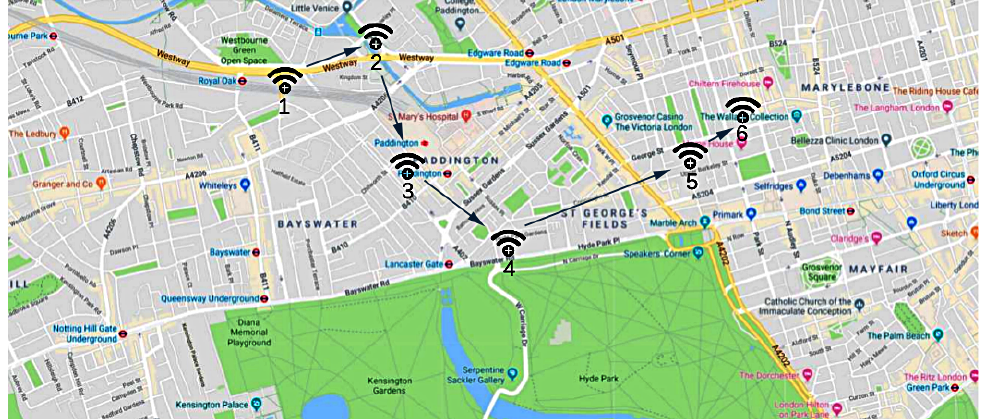
Figure 8. IoE direct